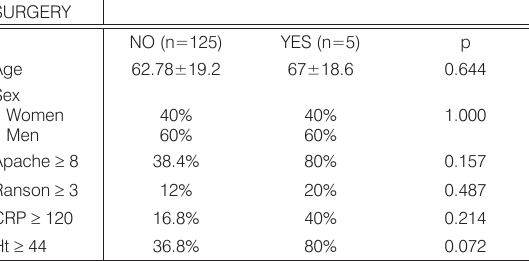
Table 4. Univariate analysis regarding surgery.